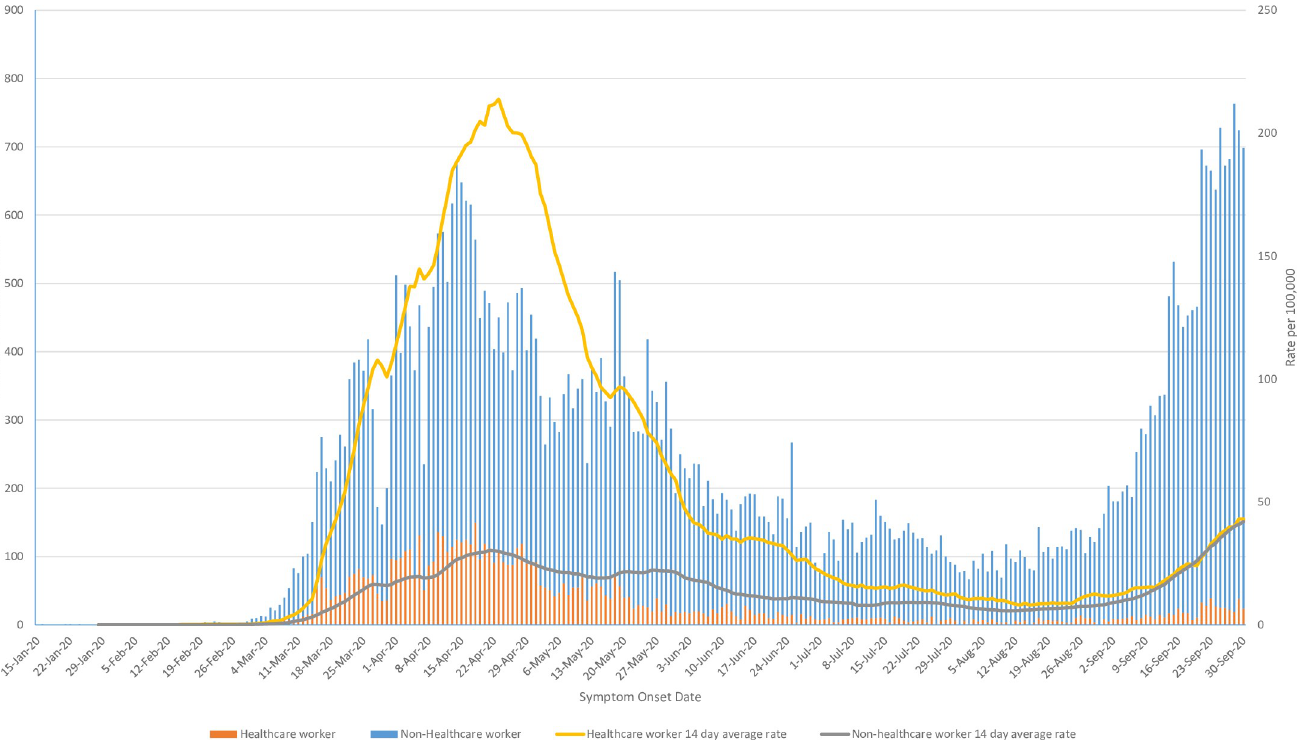
Fig 2. Epidemic curve by symptom onset date showing daily new case numbers until 30 September 2020 (left axis) and 14-day moving average of daily rate of new SARS-CoV-2 infections by symptom onset date (right axis) for healthcare workers and non-healthcare workers.